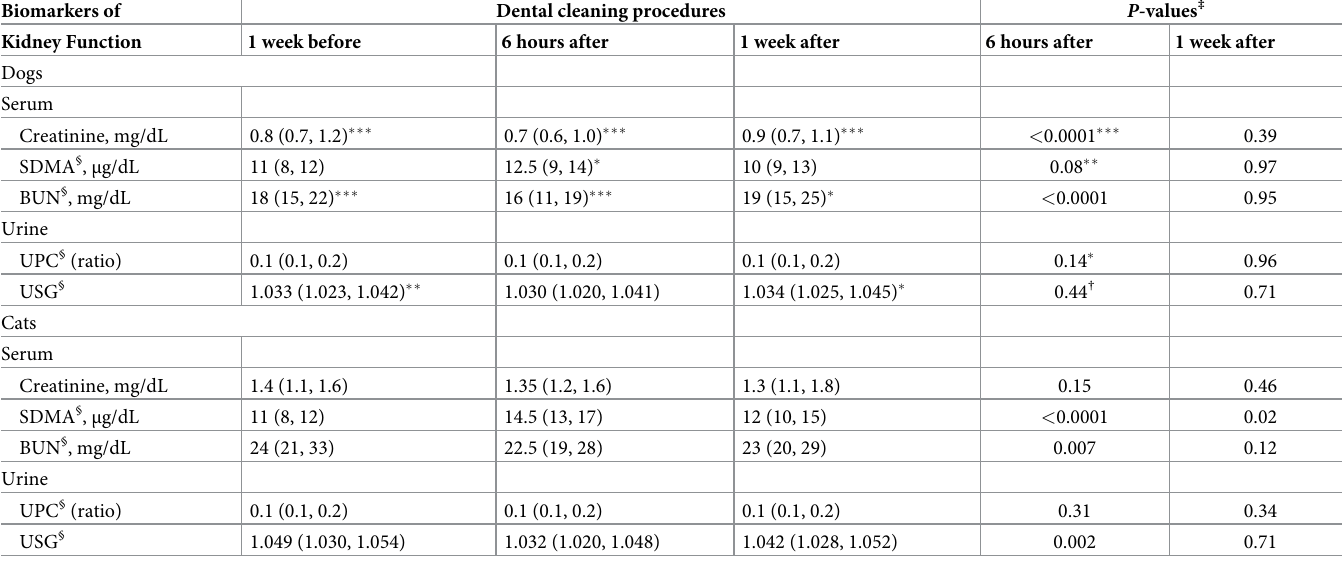
Table 1. Serum and urine kidney function biomarkers before and after general anesthesia and dental cleaning procedures in cats and dogs with periodontal disease (n = 62) � . Biomarkers of Dental cleaning